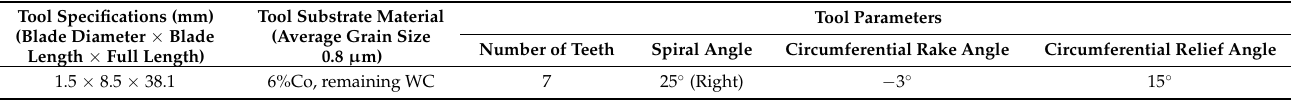
Table 1. Parameters of the tool